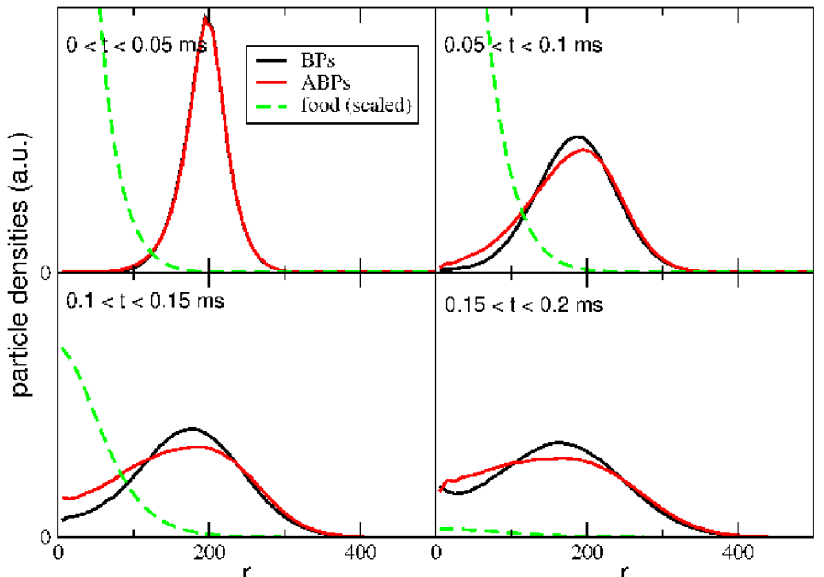
Fig 4. Transient density distributions. Time evolution of the density distributions of BPs (black) and ABPs (red), as well as food-particles (green, scaled down), for different time intervals. Initially, BPs and ABPs start at the distance r ini = 200nm to the center, boundaries are absent. A burst of food particles occurs at the center at t = 0. Upon food consumption, the density distribution of ABPs advances rapidly toward the food source. Boost time of an ABP after consumption of a food-particle: t ¼ 2 t � 18 m s B r